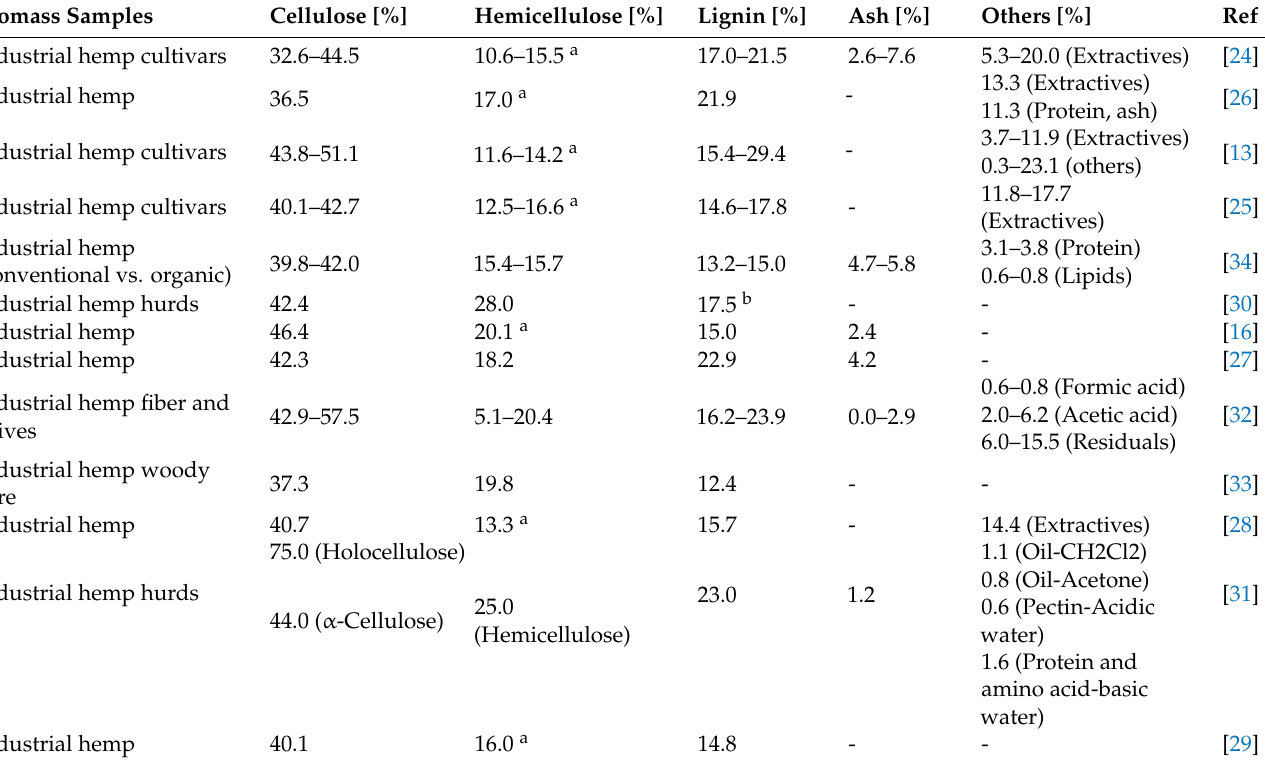
Table 1. Chemical composition of industrial hemp